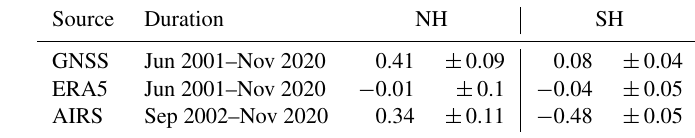
Table 2. Tropical belt expansion and contraction rates based on a subjective criterion.